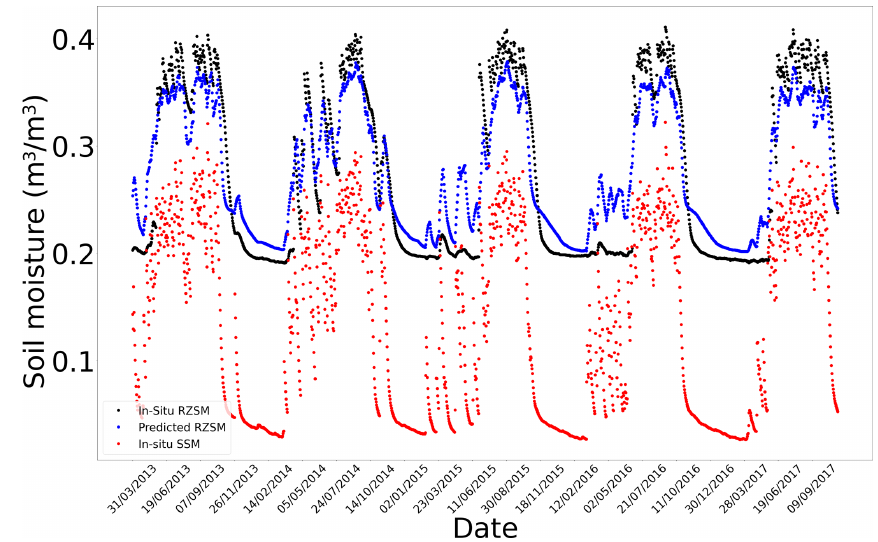
Figure E1. In situ SSM, in situ RZSM, and predicted RZSM series at station Beloufoungou Mid (AMMA-CATCH) with model ANN_SSM.